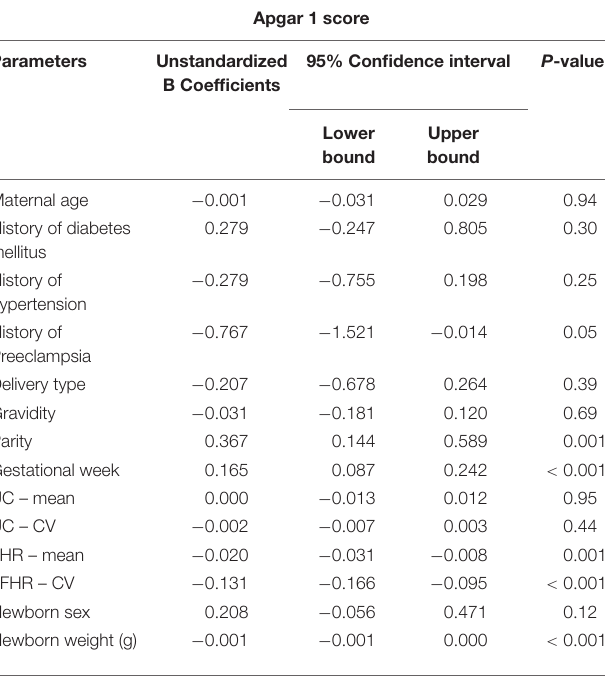
TABLE 4 | Association between maternal and newborn parameters and Apgar 1 score (1 min after birth).